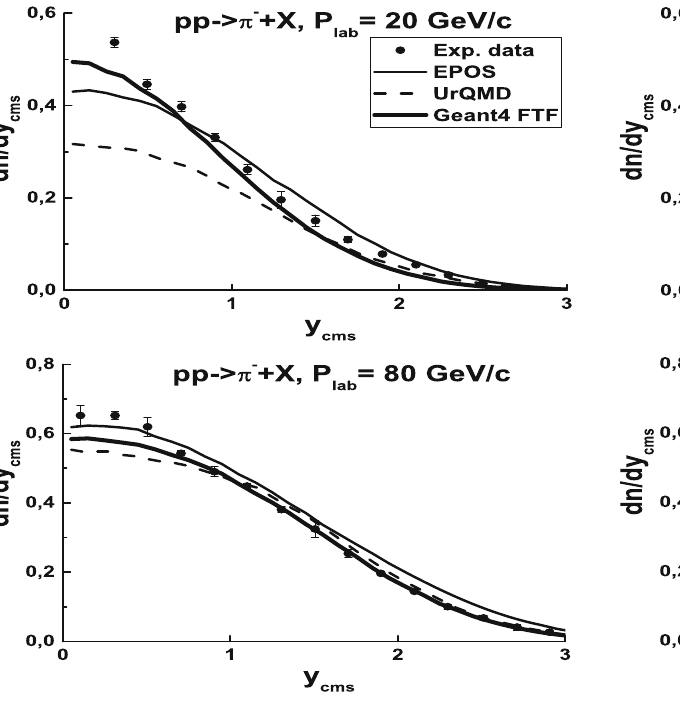
Fig. 4 Rapidity distributions, d n /d y , of π − mesons in pp interactions. The black points are the data measured by the NA61/SHINE collabora- tion [26]. The EPOS model calculations are shown by thin solid lines.